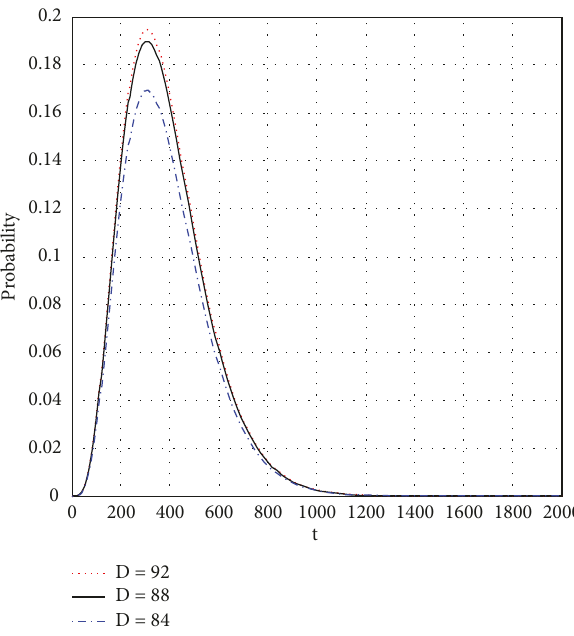
Figure 14: Sensitivity analysis of (P)